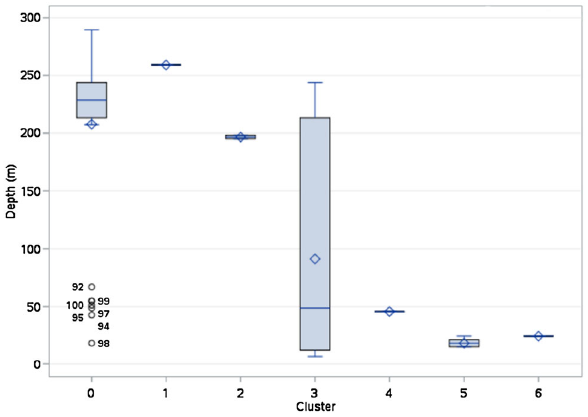
Fig. 8 Depth of tube wells within clusters in the study area in Chakaria Upazila, Bangladesh, 12 February–13 May 2016. The result of ANOVA: F -value = 12.57 and p -value \